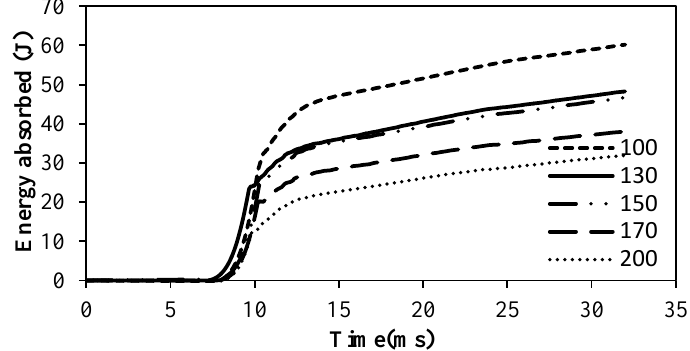
Figure 9. Impact test at constant curing time (15 min).